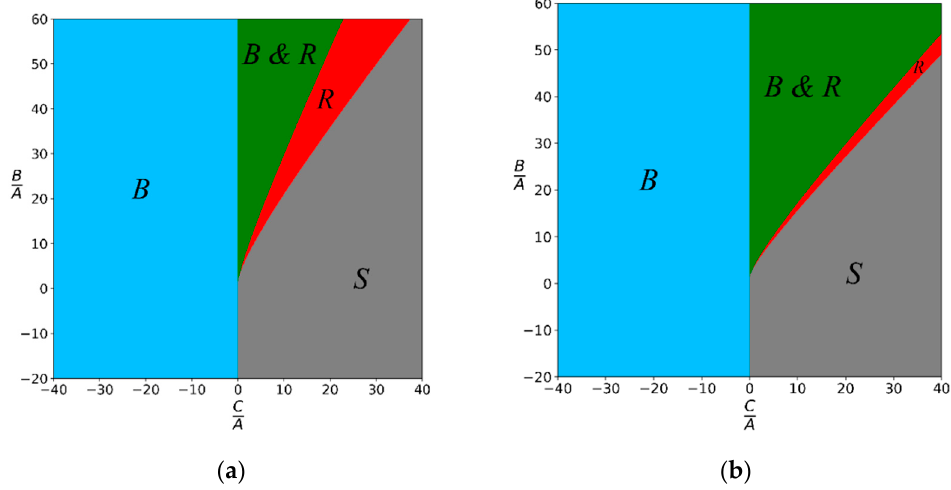
( ) V x . The diagram shows the II